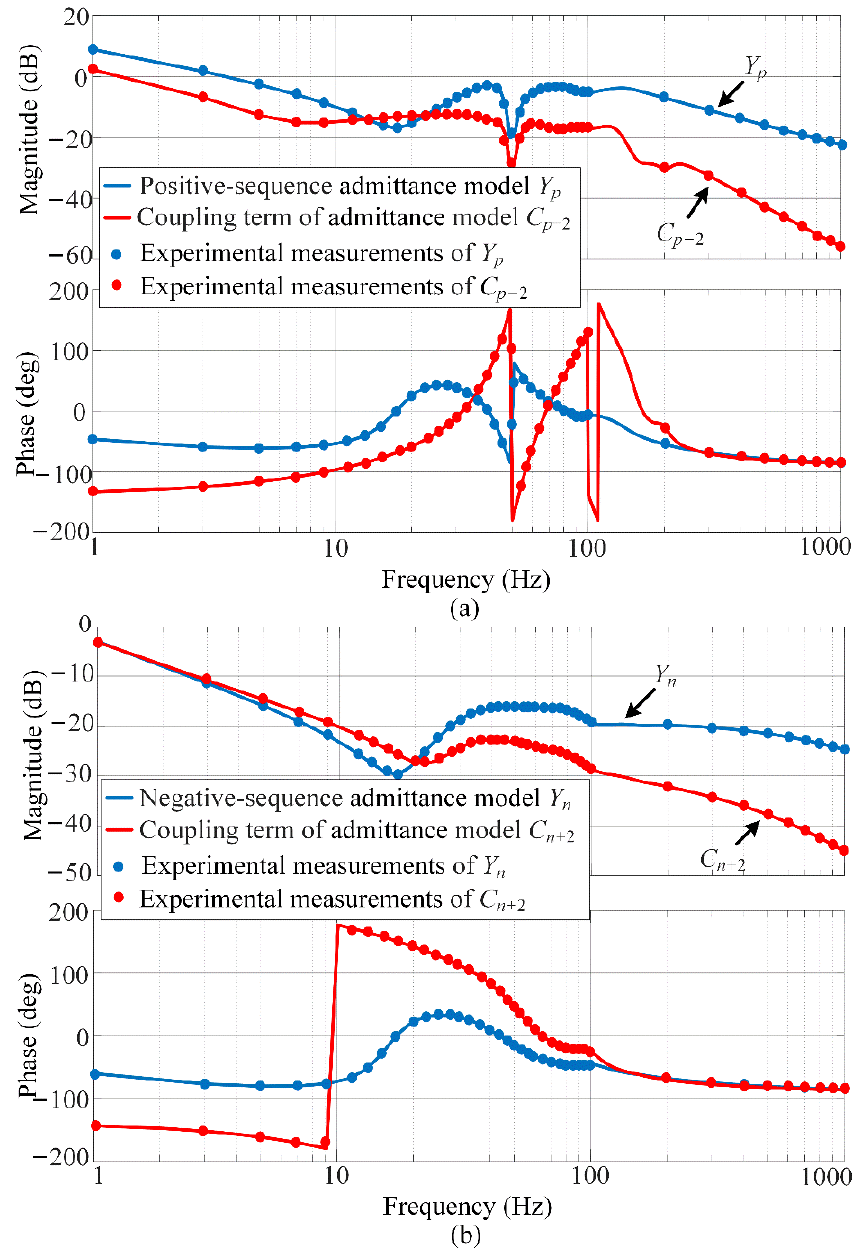
Figure 8. The theoretical and experimental validations of the admittance responses with the phase current controller only ( a ) Y p and C p − 2 . ( b ) Y n and C n +2 . Notes that blue and red lines are theoretical results, the dots are from experimental measurements.